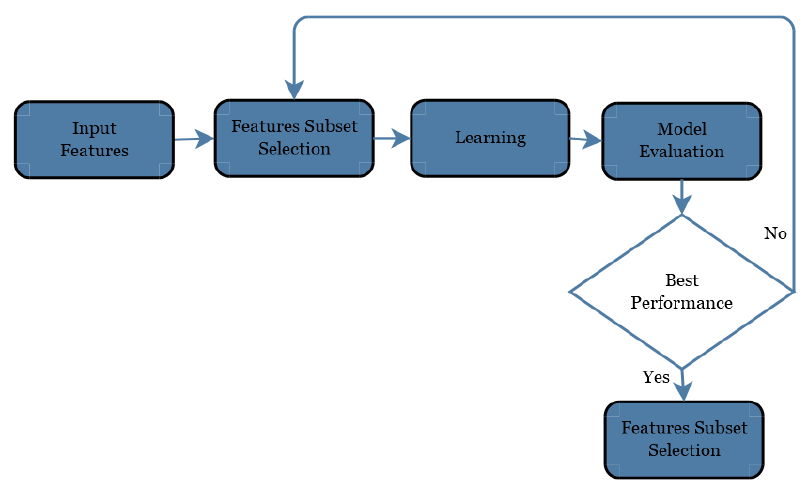
Figure 8. Wraper method for features